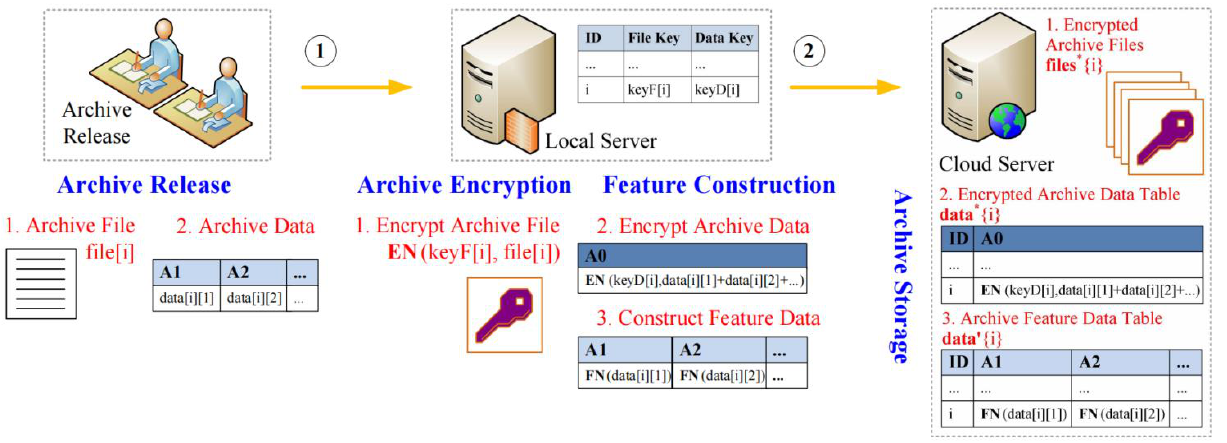
Figure 2. Implementation process of the confidentiality release model.